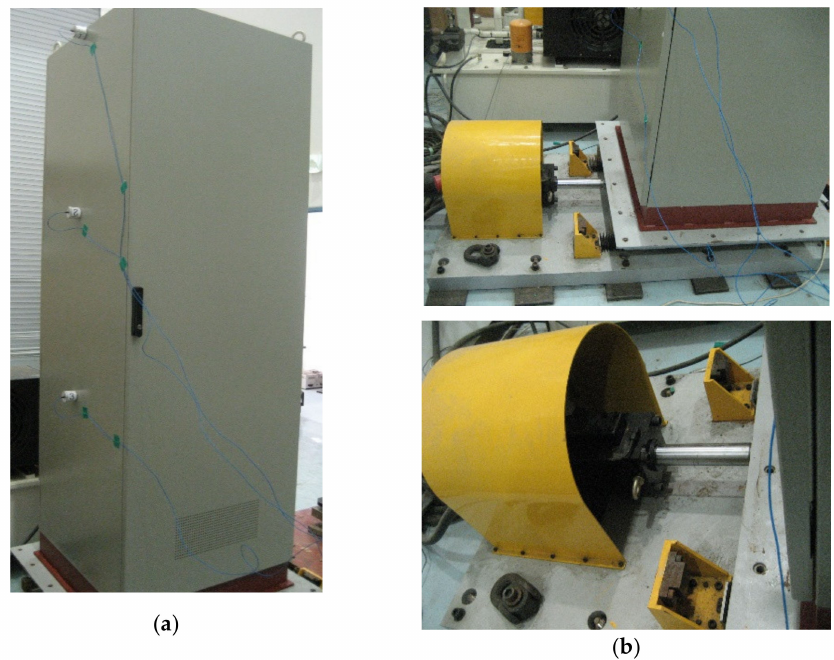
Figure 3. Shaking table test of the electrical cabinet: ( a ) Cabinet and sensors; and, ( b ) Shaking table and servo